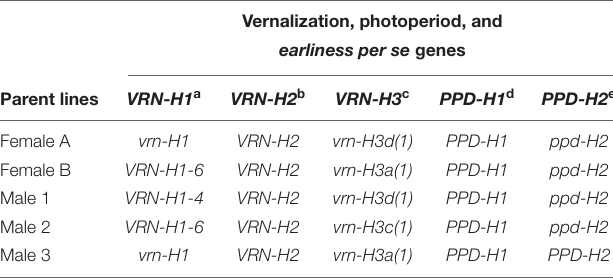
TABLE 1 | Genotypes for the genes associated with responses to vernalization and photoperiod in the parent lines under study. Vernalization, photoperiod,